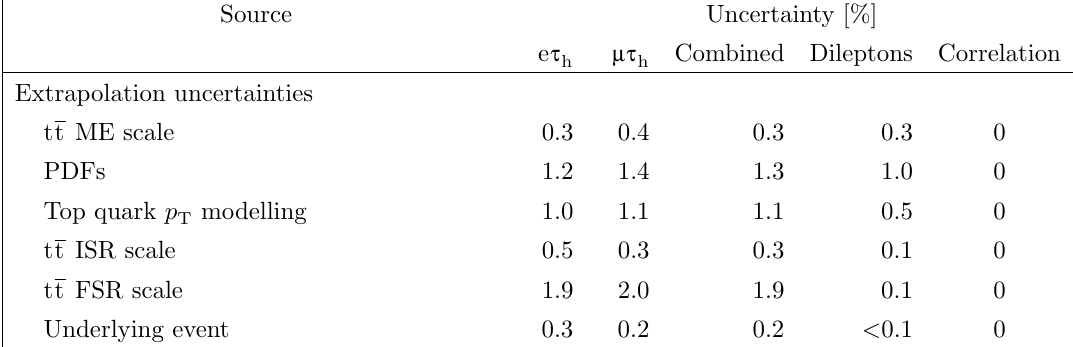
and h and light dilepton (cid:12)nal states h